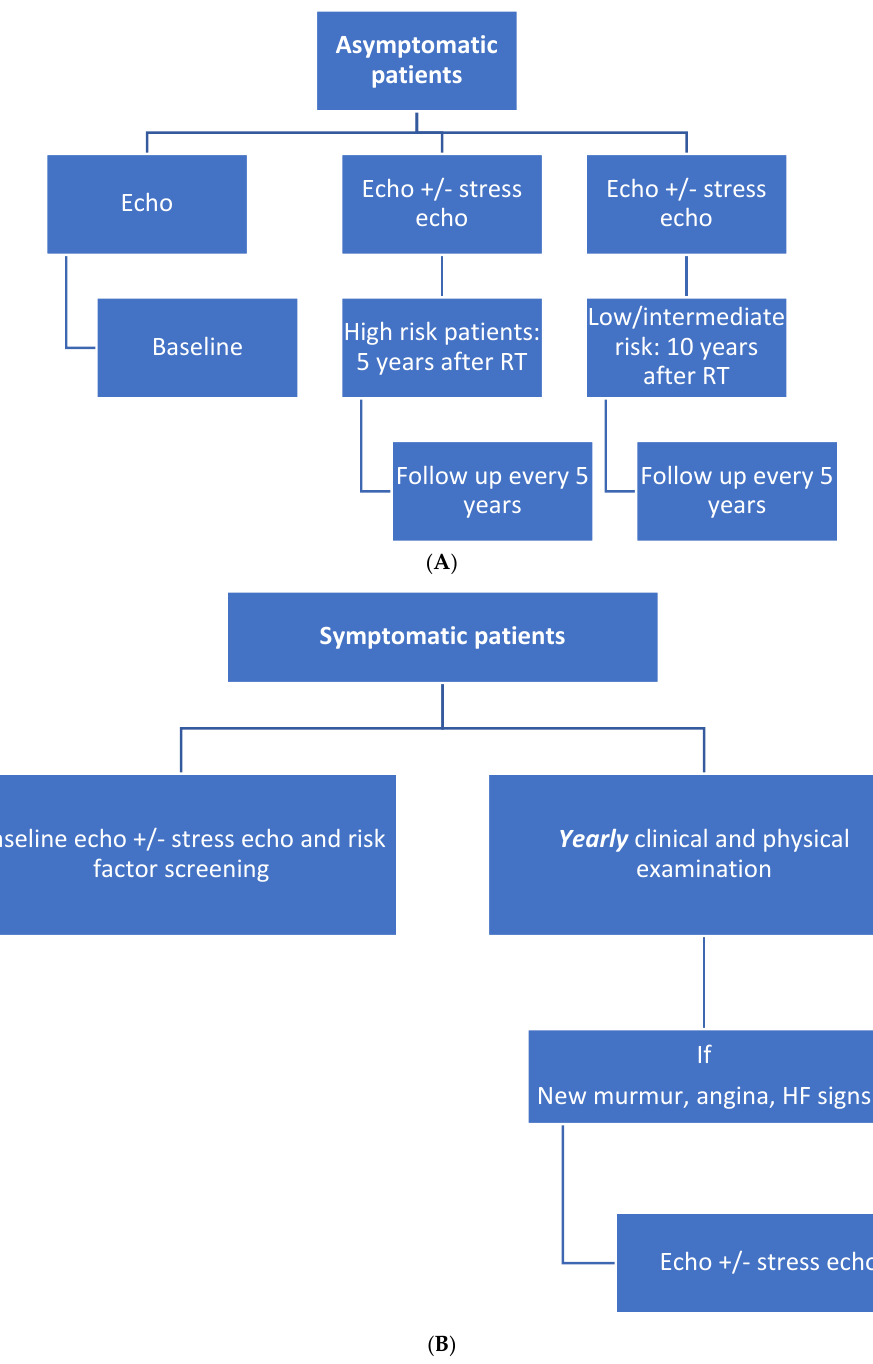
Figure 4. ( A ) Algorithm for management of asymptomatic patients after chest RT. ( B ) Algorithm for management of symptomatic patients after chest RT. [3] Abbreviations: Echo: echocardiography; HF: heart failure.